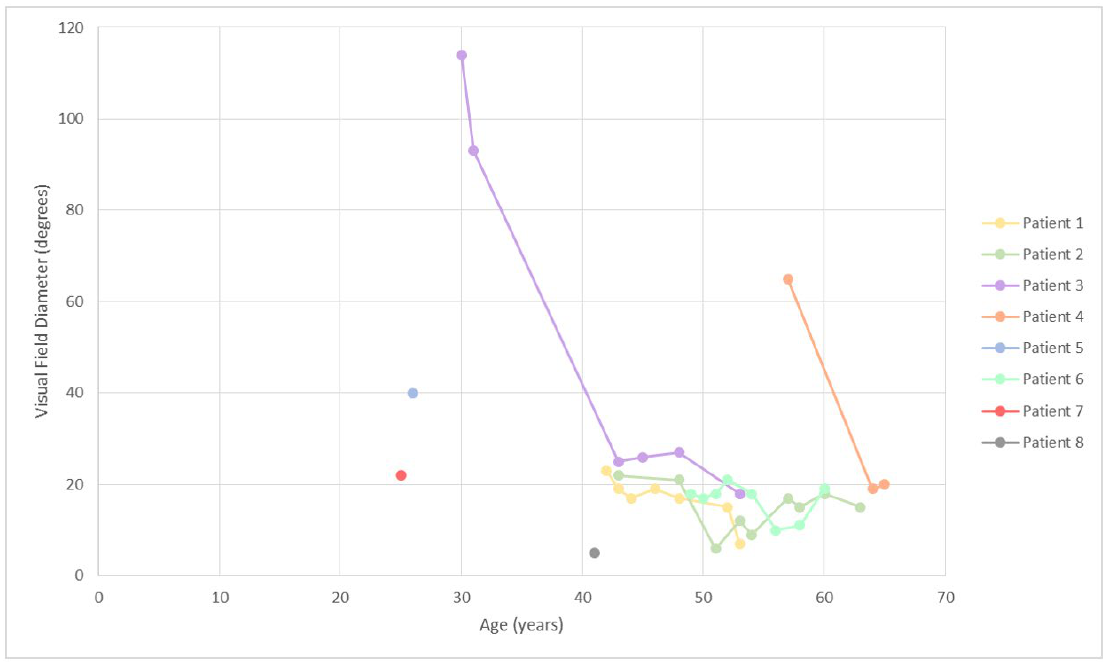
Figure 2. Visual field diameter (Isopter II/4) of the right eye in relation to age. Note the